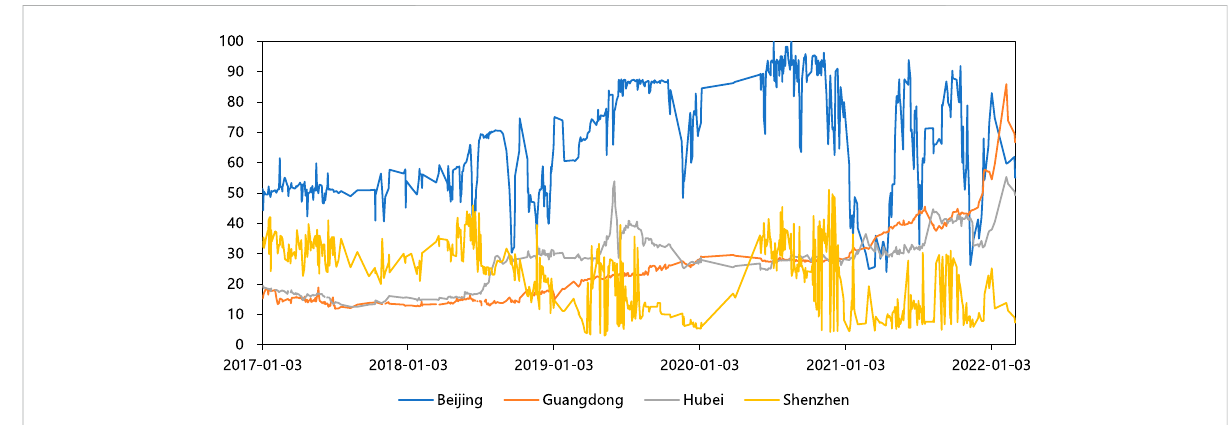
FIGURE 2 Price trends of major carbon pilots in China, including the Beijing, Guangdong, Hubei, and Shenzhen